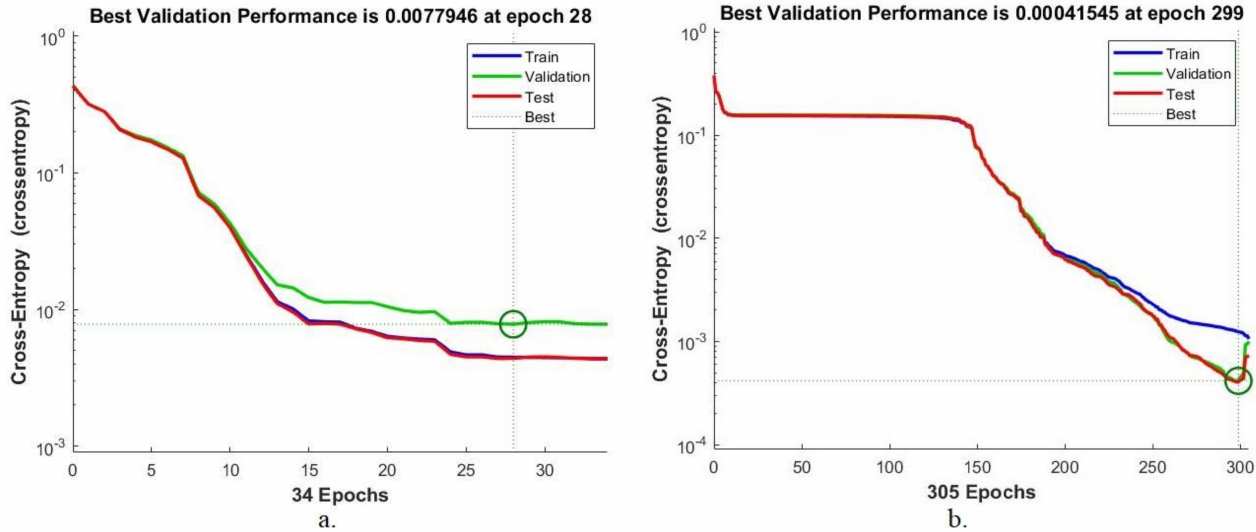
Figure 11. A display of the best performance in the evaluation of the first dataset based on mixed features in: ( a ) DenseNet-121 and hand-crafted and ( b ) ResNet-50 and